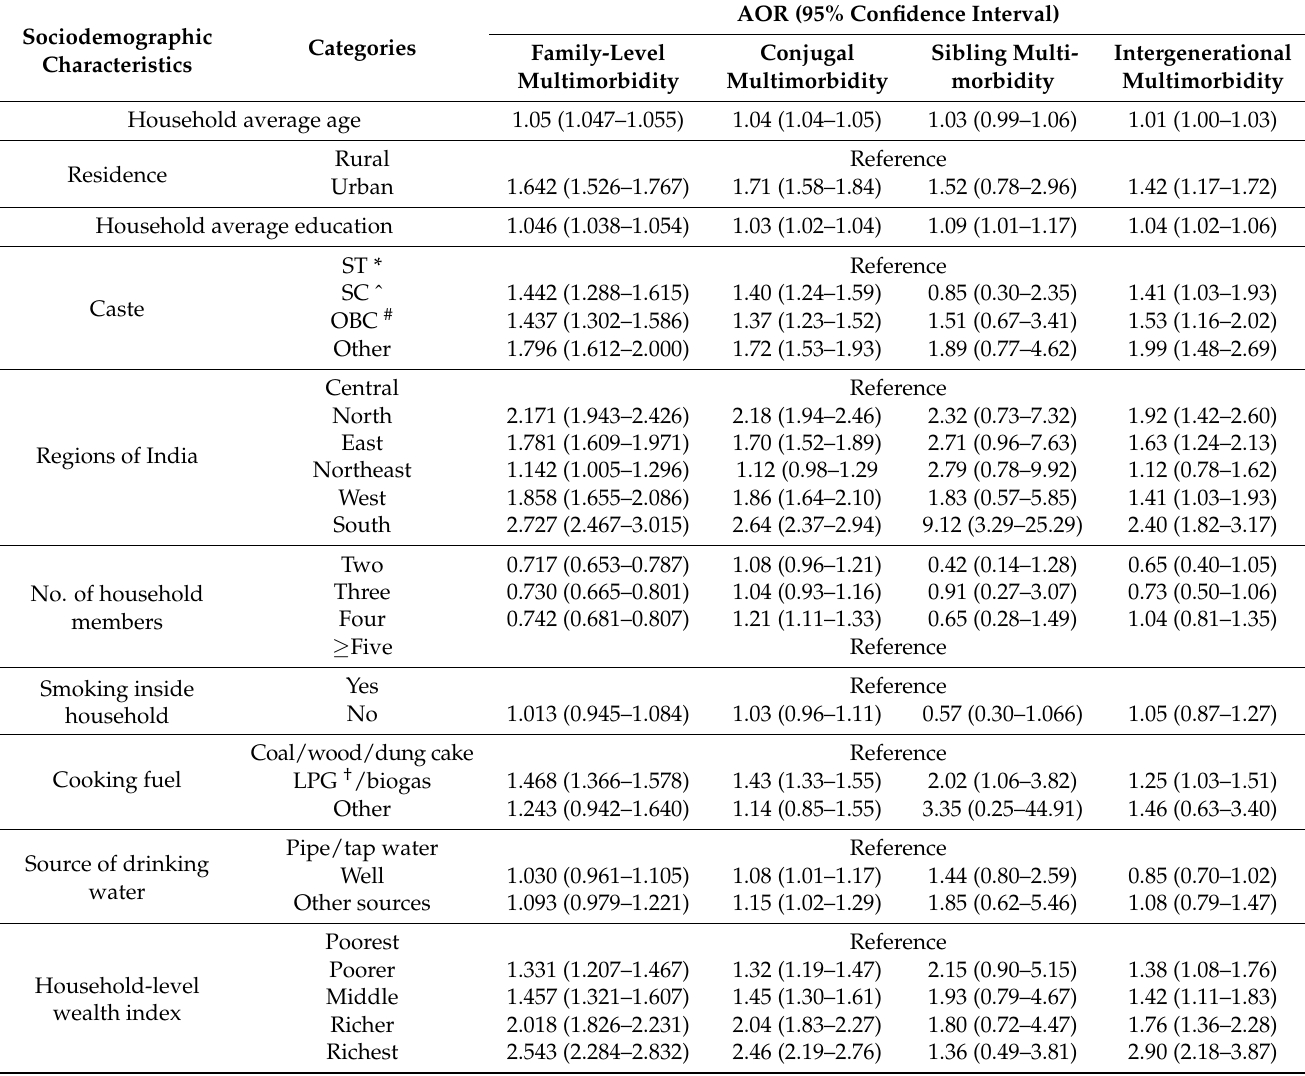
Table 4. Association between family-level, conjugal, sibling, and intergenerational multimorbidity with various sociodemographic correlates.